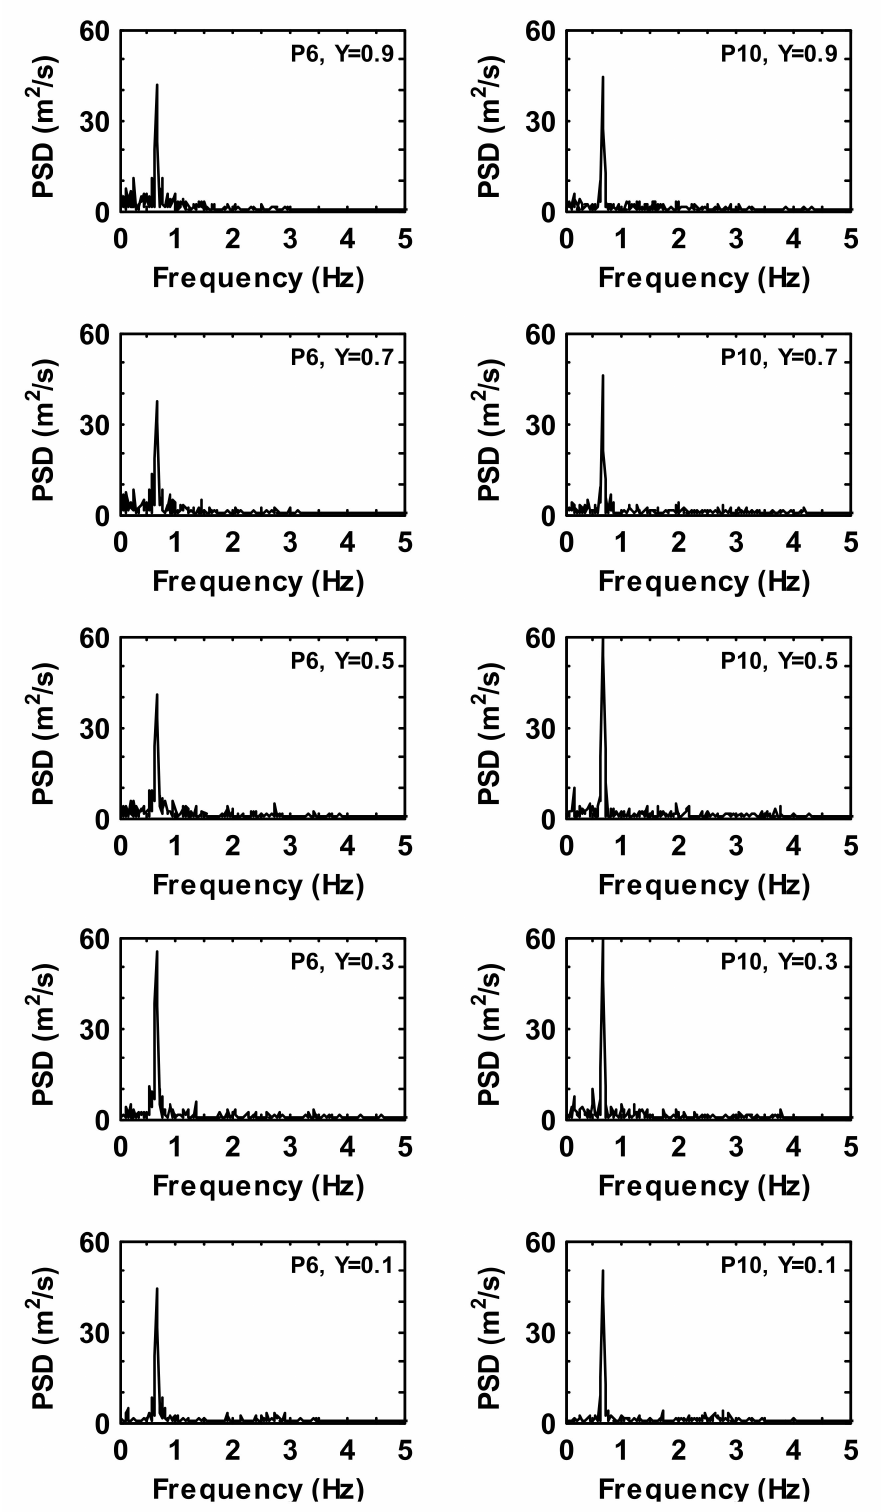
Figure 15. Power spectra density of the time history temperature fluctuations at monitoring locations P 6, P 10 for case